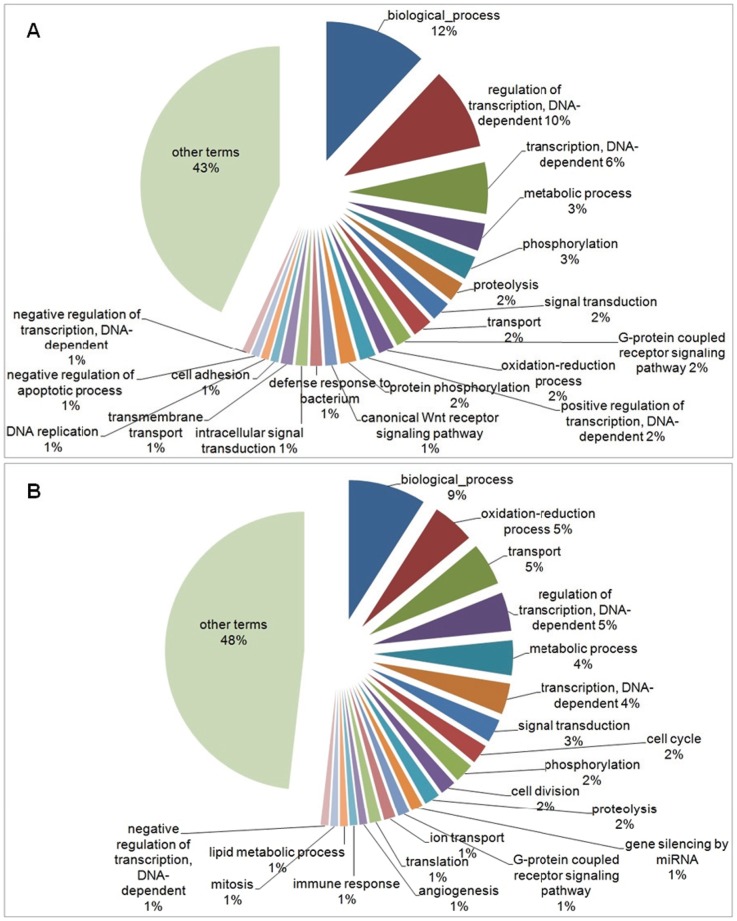
Pie-chart of Top20 GO terms for Biological Process category.Representation of Top20 GO terms results from the down- (a) and up-regulated genes (b), for Biological Process category, in the experimental group compared to control. The other terms, in addition to Top20, were represented together.